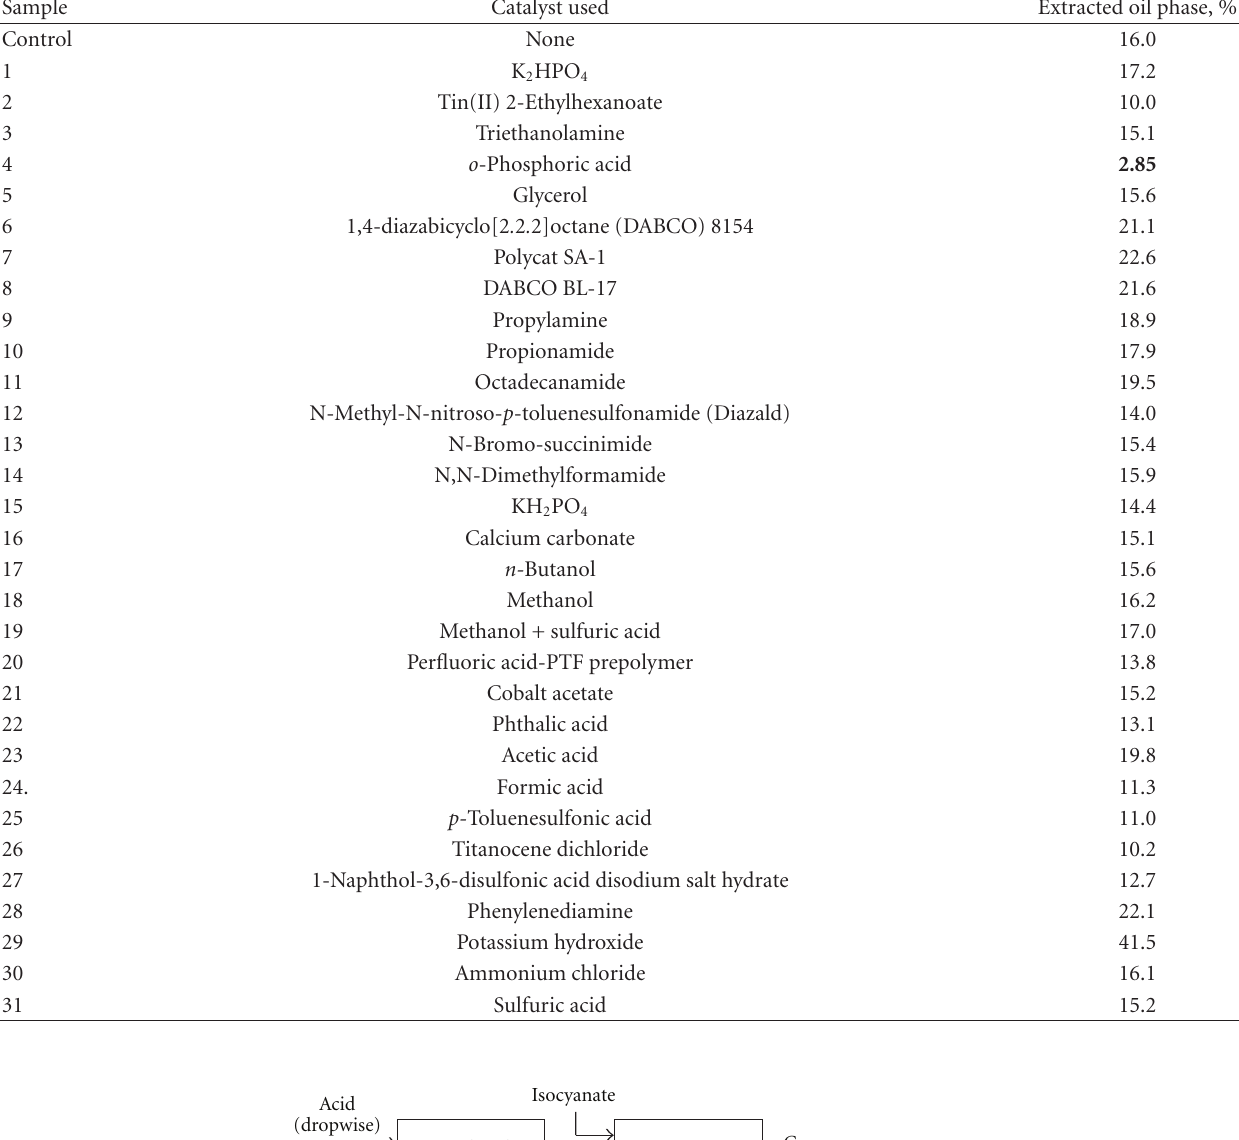
Table 1: Catalysts evaluation by extractable content method. A sample elastomeric wafer was a mixture of catalyzed ESBO (0.5% catalyst) and pMDI at 2 :1 mass ratio then cured at 140 ◦ C/24h in a convection oven.